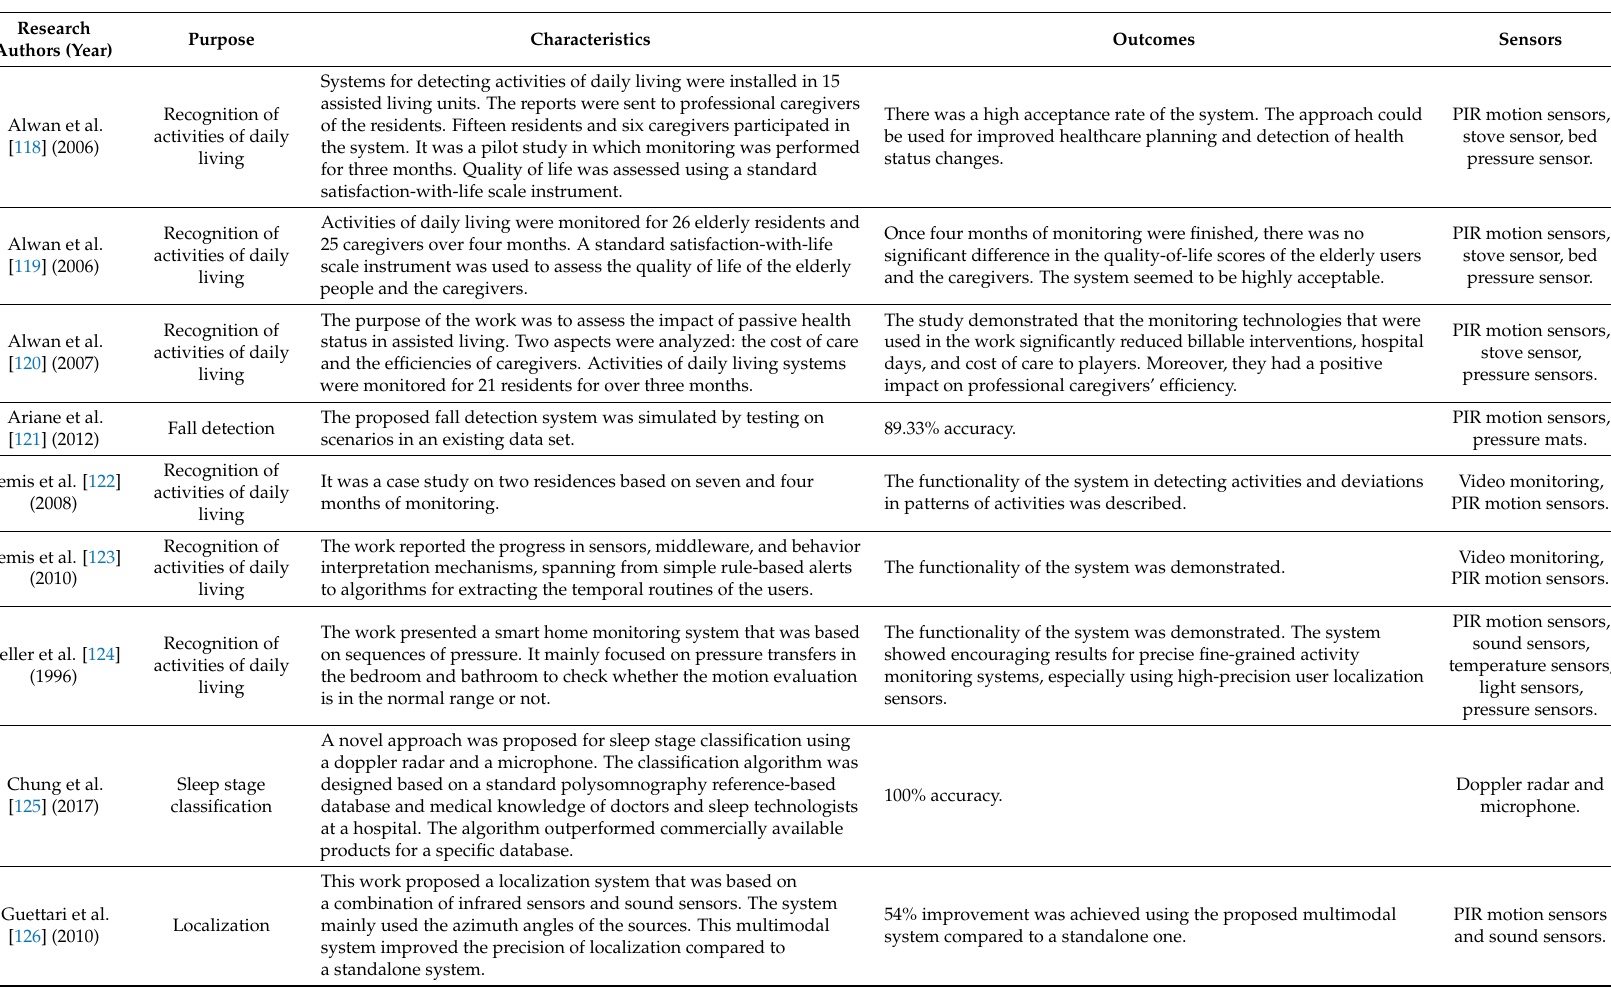
Table 8. Summary of research works that use multiple types of ambient sensor